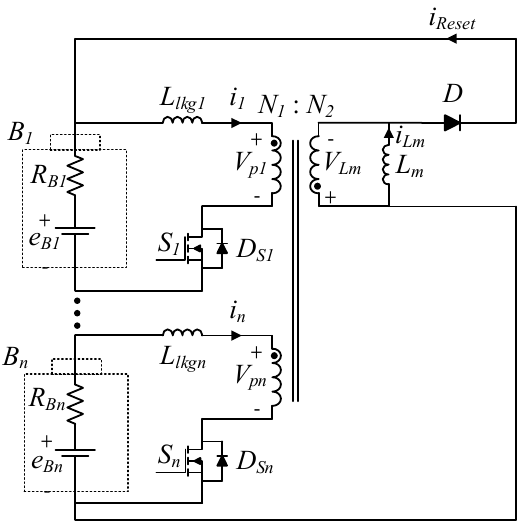
Figure 3. Voltage sensorless balancing method.